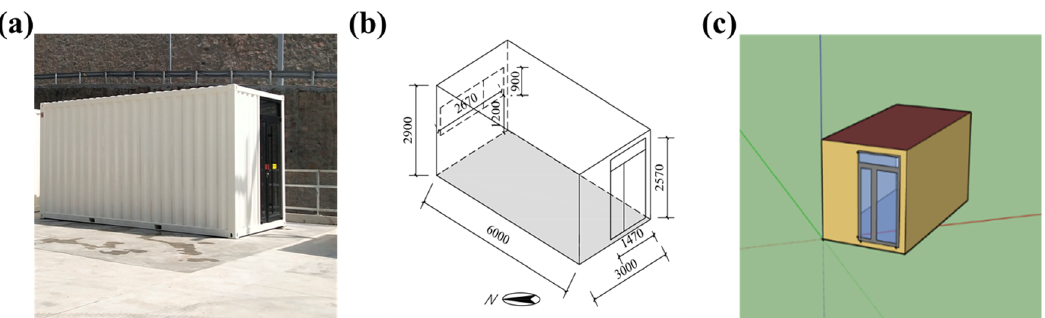
Figure 2. The grandstand and CHs of the Technical Finish Area.